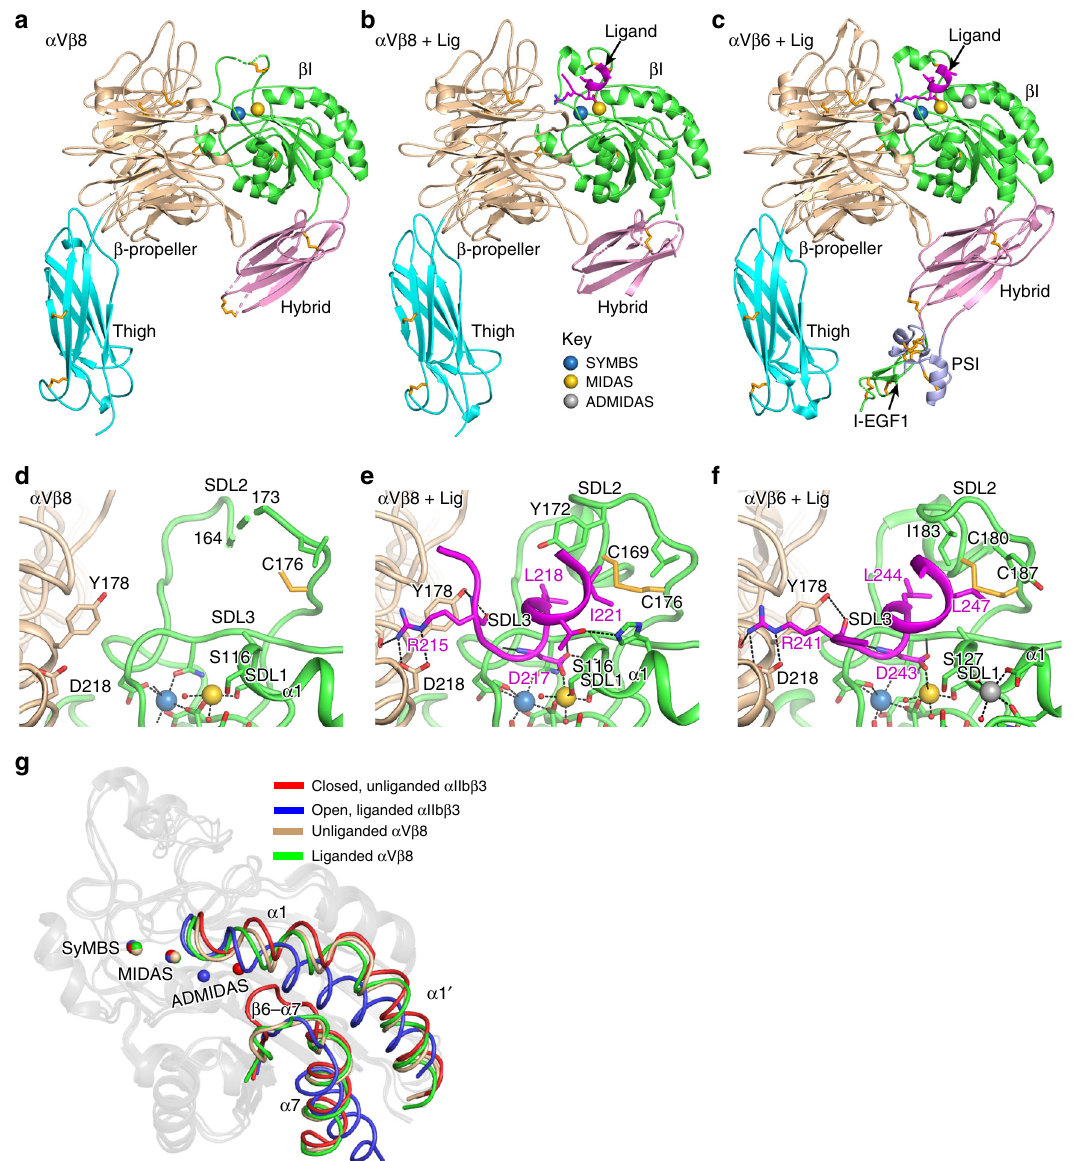
Fig. 2 α V β 8 headpiece structure and ligand-binding site. a – c Overall headpiece structures and d – f ligand-binding sites of α V β 8 ( a , d ), α V β 8 with ligand ( b , e ), and α V β 6 with ligand ( c , f ) 17 . The color scheme in d – f is the same as in a – c . In α V β 8 the PSI and EGF-1 domains are missing in electron density as are portions of the hybrid domain; shorter missing breaks in the hybrid domain are dashed. In all panels, structure representation in PyMol shows ribbon cartoon, key sidechains with oxygens in red and nitrogens in blue, disul fi des in yellow, metals in the β I domain as spheres, and metal coordination bonds and key hydrogen bonds as dashed lines. Waters are shown as small red spheres. g β I domain regions that move in allostery in typical integrins are compared to their counterparts in α V β 8 and shown in colored worm-like traces, while non-mobile regions are shown in gray ribbon cartoon. Metal ions are shown as spheres with the same color code as worm-like traces. Structures are closed, unliganded (PDB code 3T3P) and open, liganded (2VDR) α IIb β 3 and unliganded (chains A and B), and liganded (chains C and D) of α V β